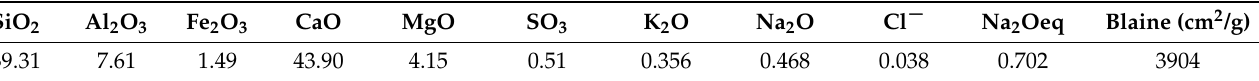
Table 2. Ground blast furnace slag